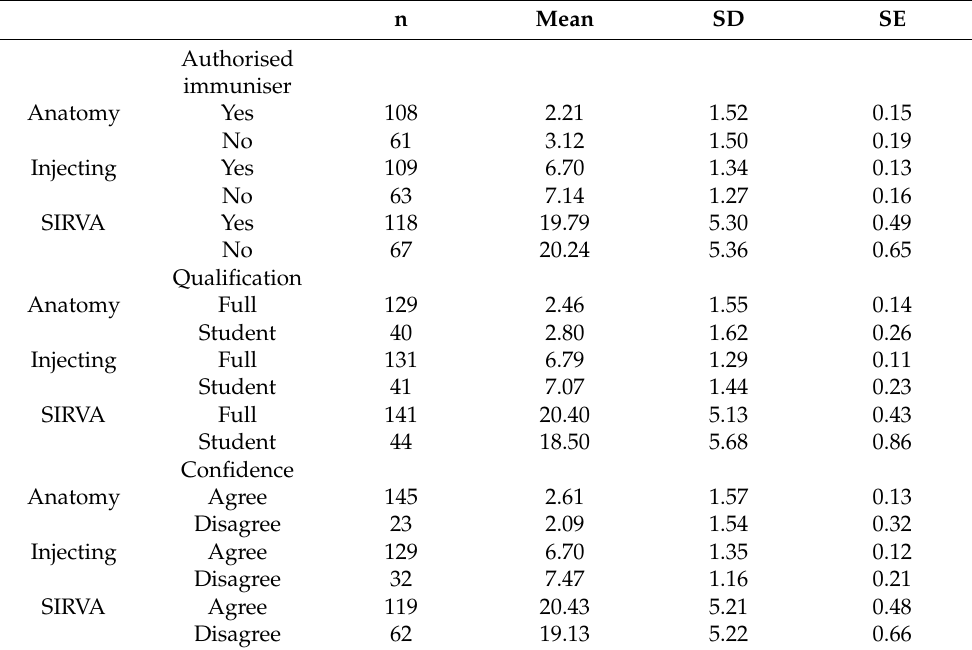
Table A2. Mean scores for anatomy, safe injecting, and SIRVA